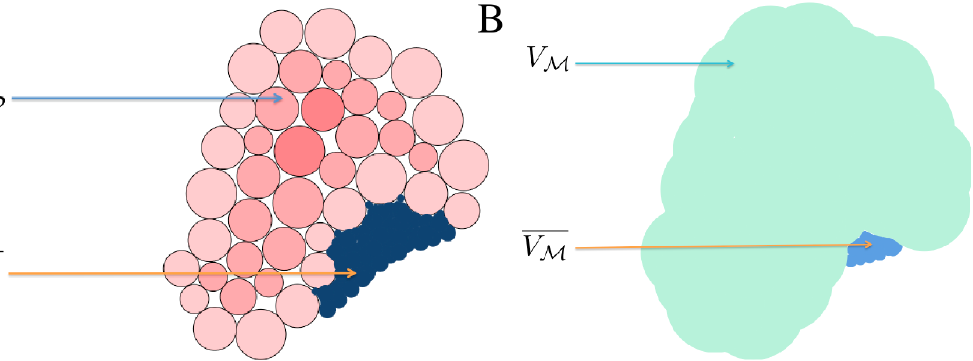
Fig 2. Schematic of representations used in our algorithms. (A) PDB schematic, showing the target volume V P and the complementary volume V P . (B) 3D EM map schematic, showing the target volume V M and the complementary volume V M . Detailed de fi nitions can be found in the Materials and Methods